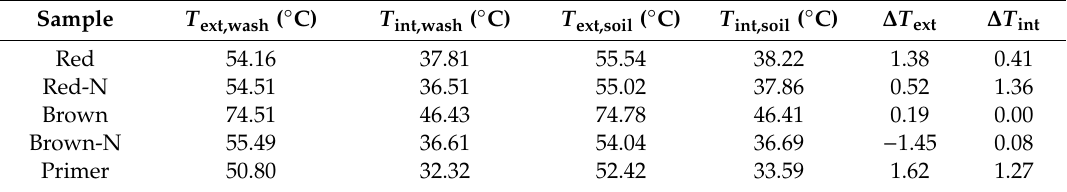
Table 8. Comparison of plateau temperatures, both external and internal, between soiled samples and washed samples. Δ T ext and Δ T int are the differences between the soiled samples compared with the washed samples for external and internal plateau temperatures, respectively.